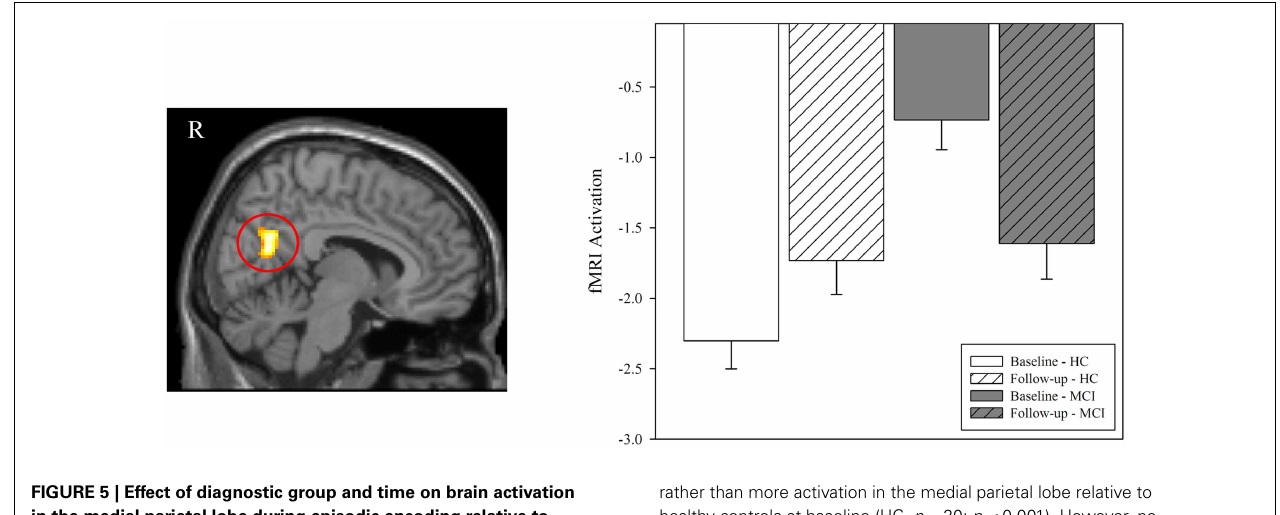
FIGURE 5 | Effect of diagnostic group and time on brain activation in the medial parietal lobe during episodic encoding relative to rest . Mean fMRI activation was extracted from a region of interest (ROI) in the medial parietal lobe that was observed to be significantly associated with diagnostic group at baseline (left panel; also see Figure 4A ). Group means demonstrated significant effects of diagnostic group and time. Clarifying the results seen in the voxel-wise analysis ( Figure 4A ), MCI patients ( n = 18) showed less deactivation